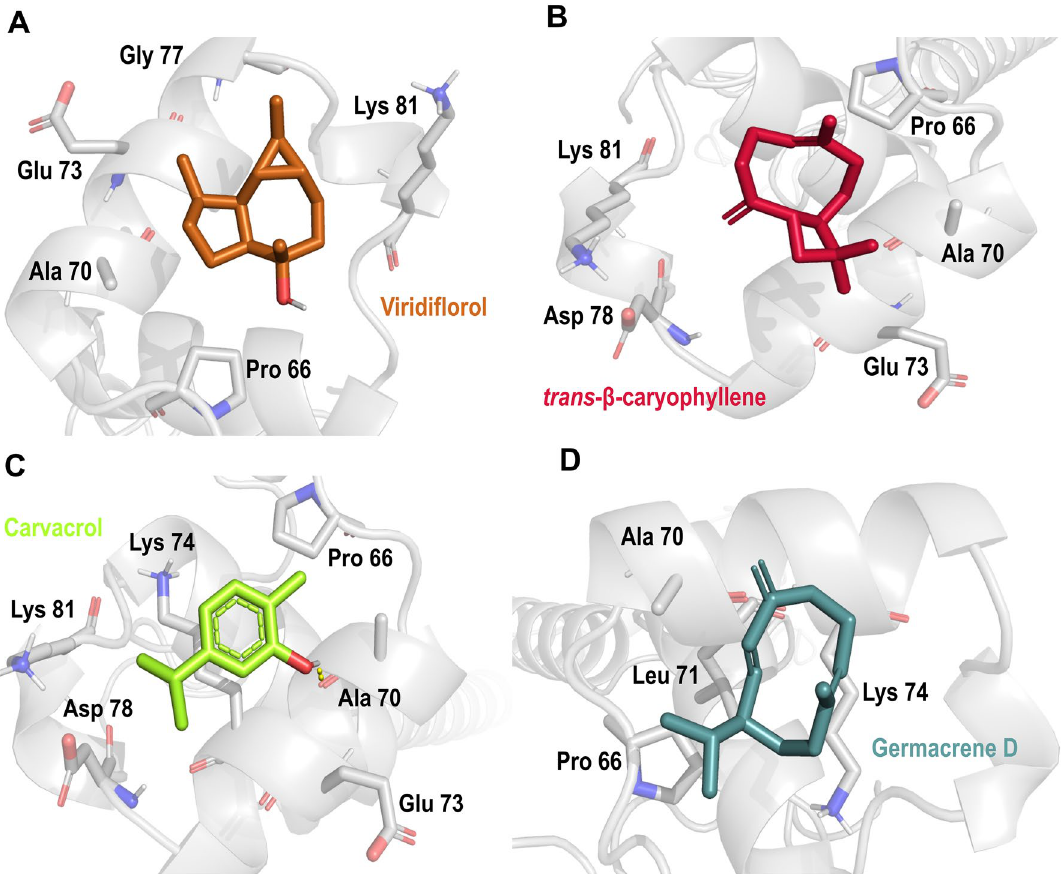
Figure 8. Docking pose of selected secondary metabolites on mitochondrial complex IV in Aedes aegypti . ( A ) viridiflorol; ( B ) trans- β-caryophyllene; ( C ) carvacrol; ( D ) germacrene D. Mitochondrial complex IV’ residues are colored according to the atom type of the interacting amino-acid residues (protein’s carbon, gray; oxygen, red; nitrogen, blue). The protein–ligand interactions are represented by dash lines as follows: hydrogen bond interactions are colored in